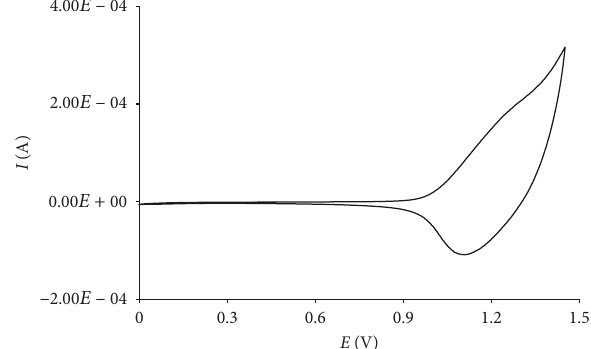
Figure 2: Voltammetric characterization of a poly(4,4 in 0.1M TEAFP 6 /acetonitrile solvent system ( Q 1 scan rate 100mV s (cid:30) −